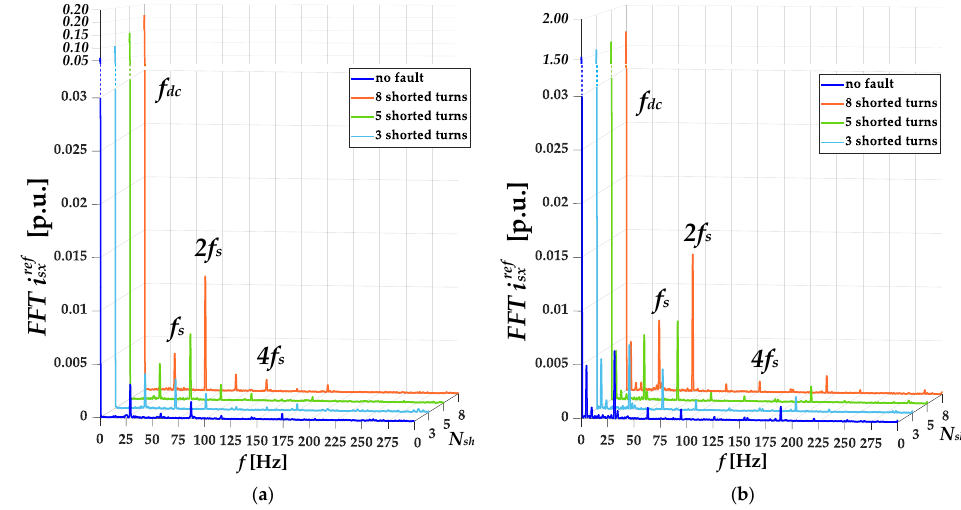
Figure 9. Spectral analysis of reference i sx current with several short-circuit turns with ω m = 0.6 ω mN for ( a ) no-load operation and ( b ) nominal load operation. FFT: fast Fourier transform